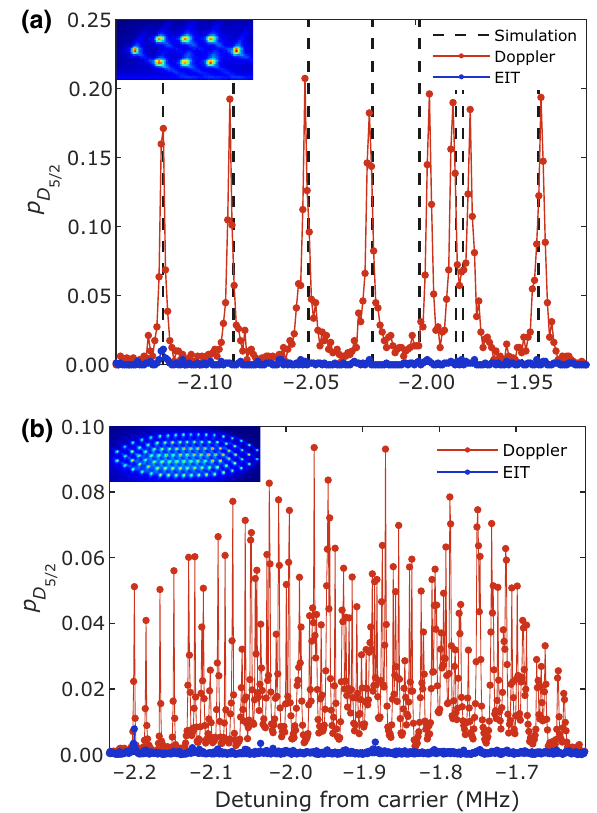
FIG. 7. EIT cooling of (a) an eight-ion crystal and (b) a 105-ion crystal. The red data points represent the red-sideband excitation spectrum of the out-of-plane modes after only Doppler cooling and the blue data points represent the red-sideband exci- tation spectrum of the out-of-plane modes with additional EIT cooling for 300 µ s. The most prominent peaks in the EIT-cooled spectra are the center-of-mass modes, which heat up during the ˙¯ measurement time in proportion to nN . Note that the solid red and blue lines are guides for the eye. The dashed vertical lines in (a) show the simulated mode frequencies for the given trapping parameters obtained from pseudopotential